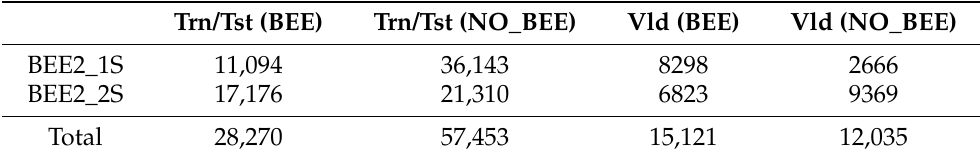
Table 8. Numbers of images in BEE2_1S and BEE2_2S (collectively referred to as BEE2) used for training, testing, and validation.